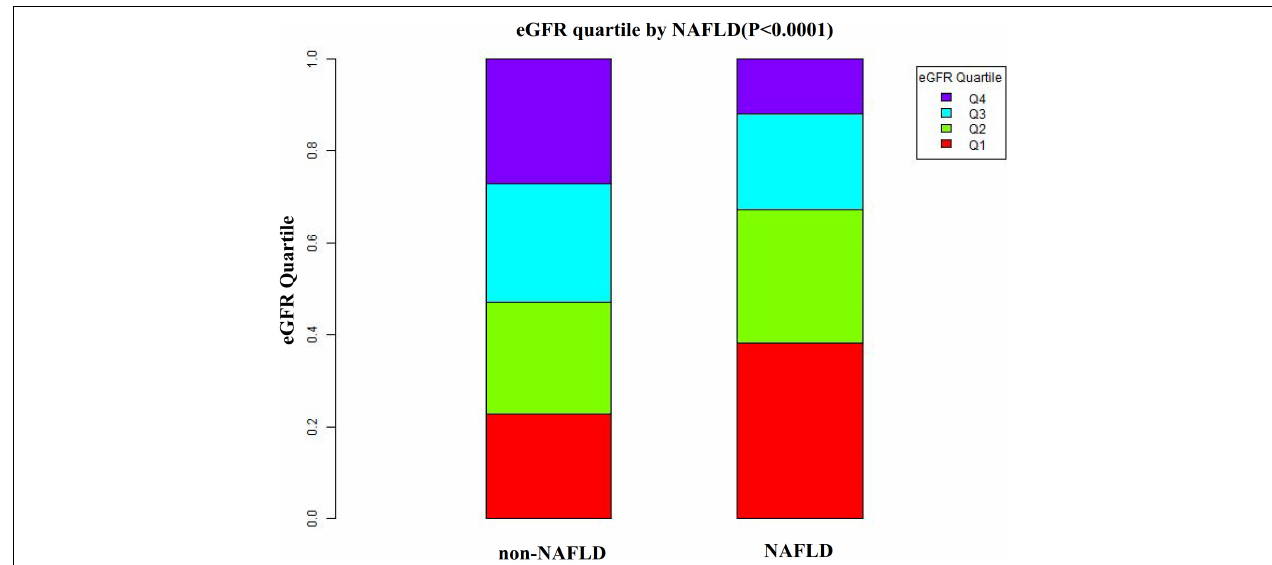
FIGURE 3 | Data visualization of eGFR of all participants from the NAFLD and non-NAFLD groups. This figure indicated that the distribution level of eGFR in the NAFLD group was lower. In contrast, the eGFR level in the non-NAFLD group was relatively higher.